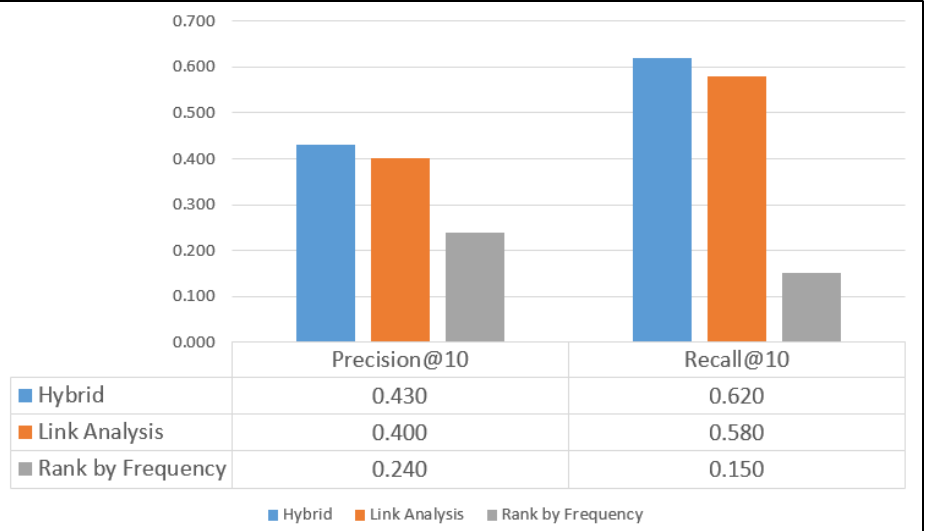
Figure 10. Results for the Weeplaces dataset.